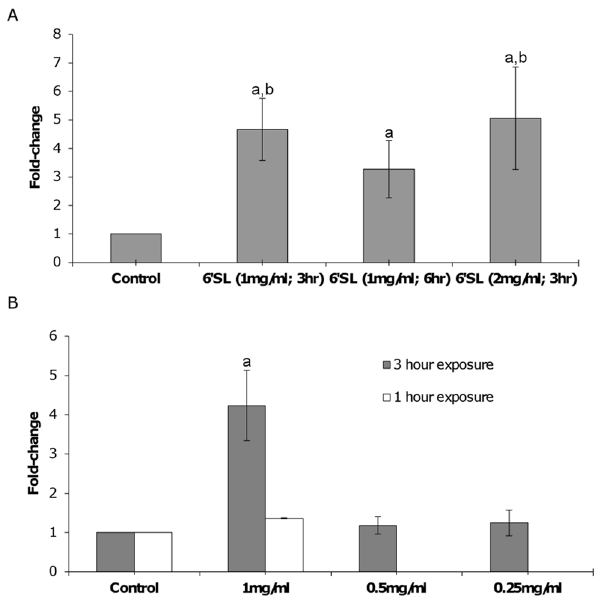
Figure 3. Dose-response of B. longum subsp. infantis ATCC 15697 to 6 9 sialyllactose and subsequent adherence to HT-29 cells. (A) Bacterial exposure to original conditions (1 mg/ml; 3 hours), increased duration (1 mg/ml; 6 hours) or increased concentration (2 mg/ml; 1 hour) in comparison to non-treated control bacteria. (B) Exposure to a gradient of 6 9 sialyllactose was assayed over 3 hours (gray shading) or control and 1 mg/ml for 1 hour exposure (white shading). Results are expressed as fold-change in percent adhesion in relation